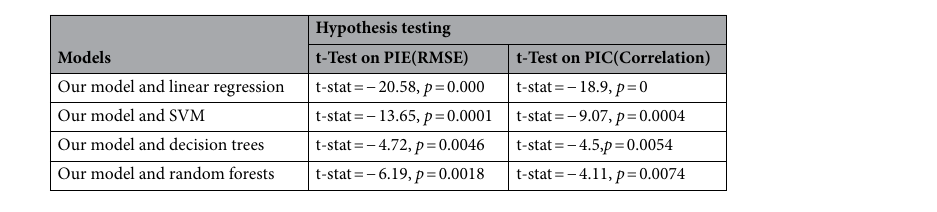
Table 2. Statistical significance test for model comparison.